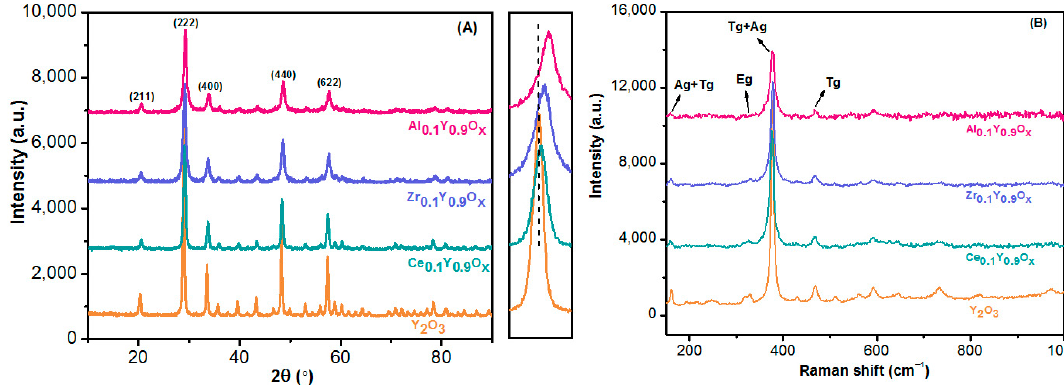
Figure 1. ( A ) XRD patterns and ( B ) Raman spectra of the supports.